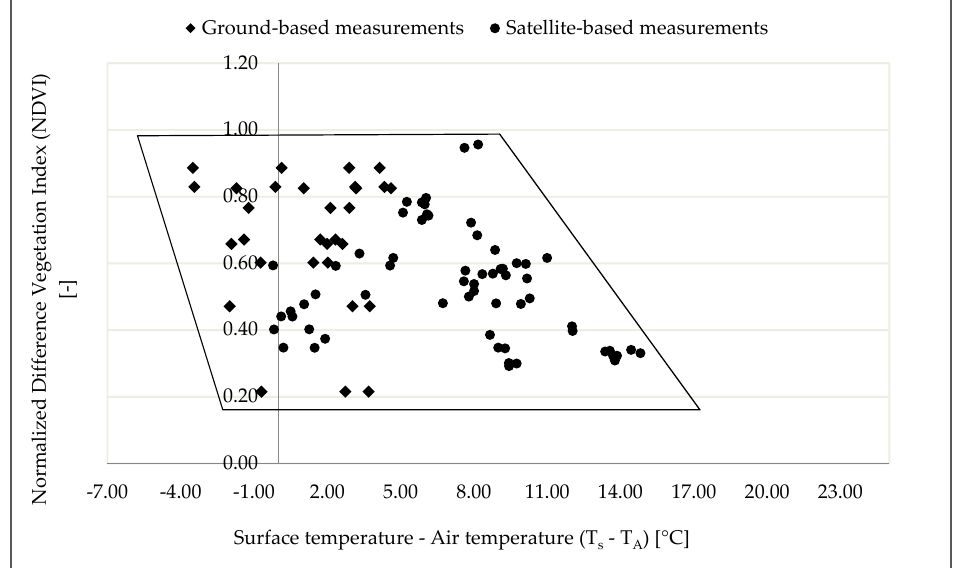
Figure 7. Vegetation Index / Temperature (VIT) trapezoid estimated for winter wheat from ground-based and satellite data.